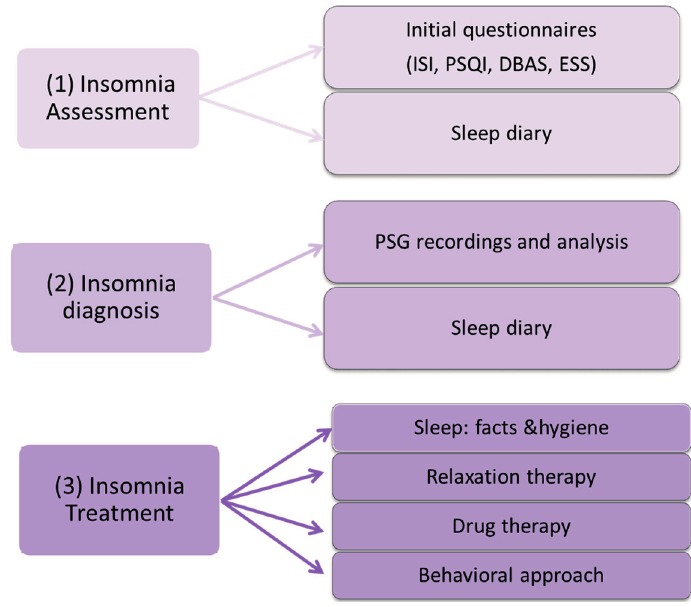
Figure 2. Main steps for insomnia assessment and